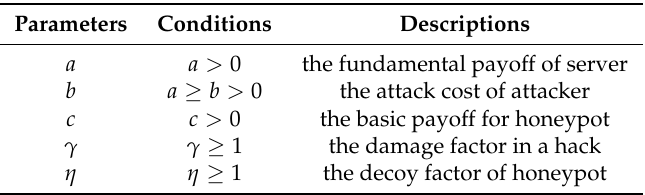
Table 5. List of parameters of the